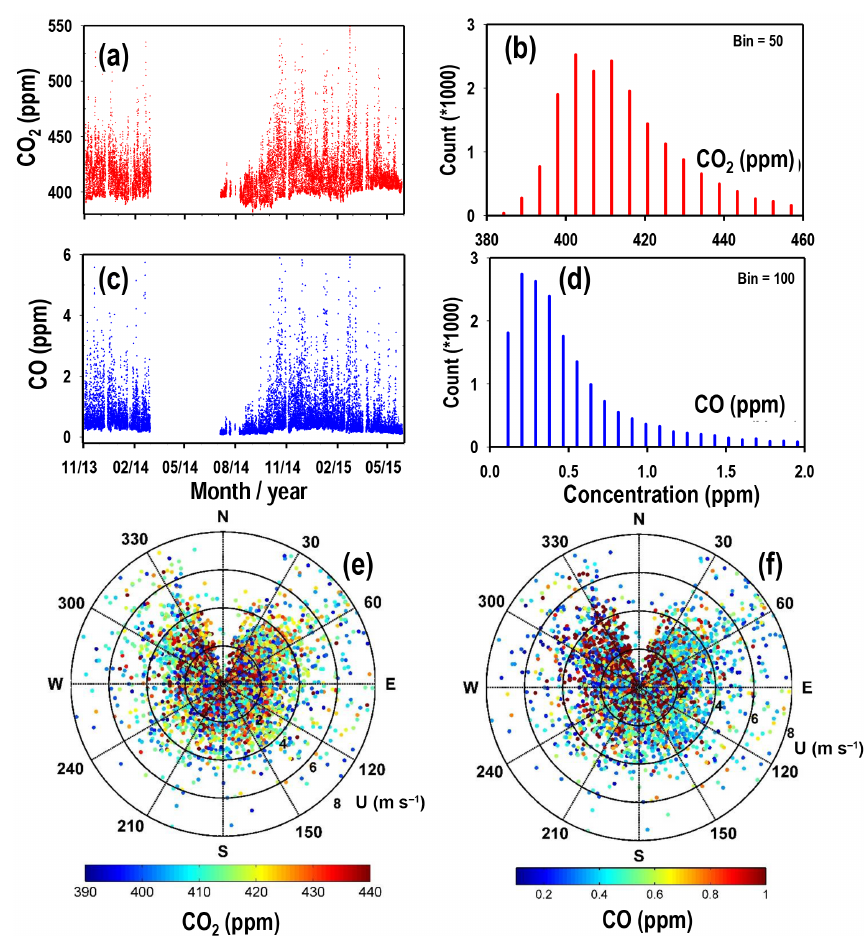
Figure 3. (a, c) Time series of 30min averaged values of CO 2 and CO measured at Ahmedabad for the study period. (b, d) The frequency distribution in CO 2 and CO concentrations for the study period using a 30min mean of the gases. (e, f) The polar plots show the variation of 30min averaged CO 2 and CO at this site with wind direction and speed during the study period except July, August and September due to unavailability of meteorology